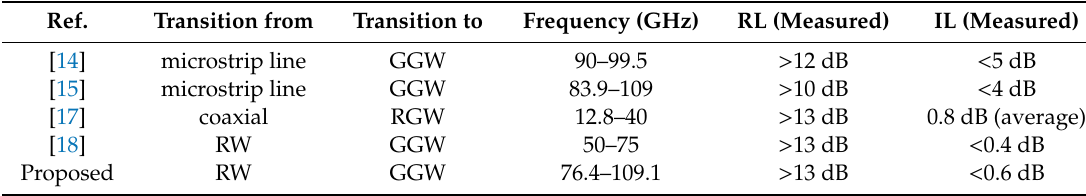
Table 2. Gap waveguide transitions and